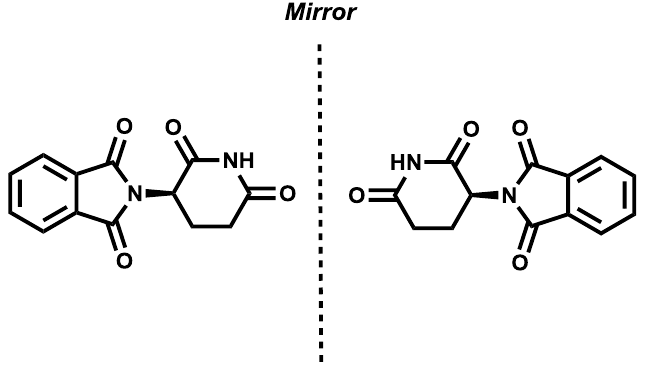
Figure 2. ( R )-Thalidomide ( left ) and ( S )-Thalidomide ( right ).